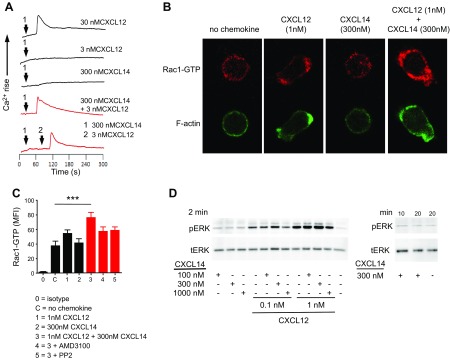
CXCL14 synergized with CXCL12 in Ca2+ mobilization and Rac1 activation responses but not in ERK1/2 phosphorylation responses. A) Real-time changes in [Ca2+]i concentrations in CXCR4-transfected cells in response to indicated chemokines. All experiments were performed at least twice. B) Polarization of primary T cells was visualized by staining of F-actin and Rac1-GTP followed by confocal microscopy. C) Rac1 activation was measured in flow cytometry by determining mean fluorescent intensity of Rac1-GTP staining in primary T cells by using an Ab that recognizes active GTP-bound Rac1. For each analysis, 10,000 cells were measured. Data are means + sem of 5 experiments derived from individual donors. D) CXCR4-transfected cells were treated with chemokines as shown and then processed for Western blot analysis. ERK1/2 phosphorylation was determined with a phospho-ERK1/2–specific Ab. pERK, phosphorylated ERK1/2; tERK, total ERK1/2 protein. Data are representative of 4 experiments with similar results. ***P < 0.001.